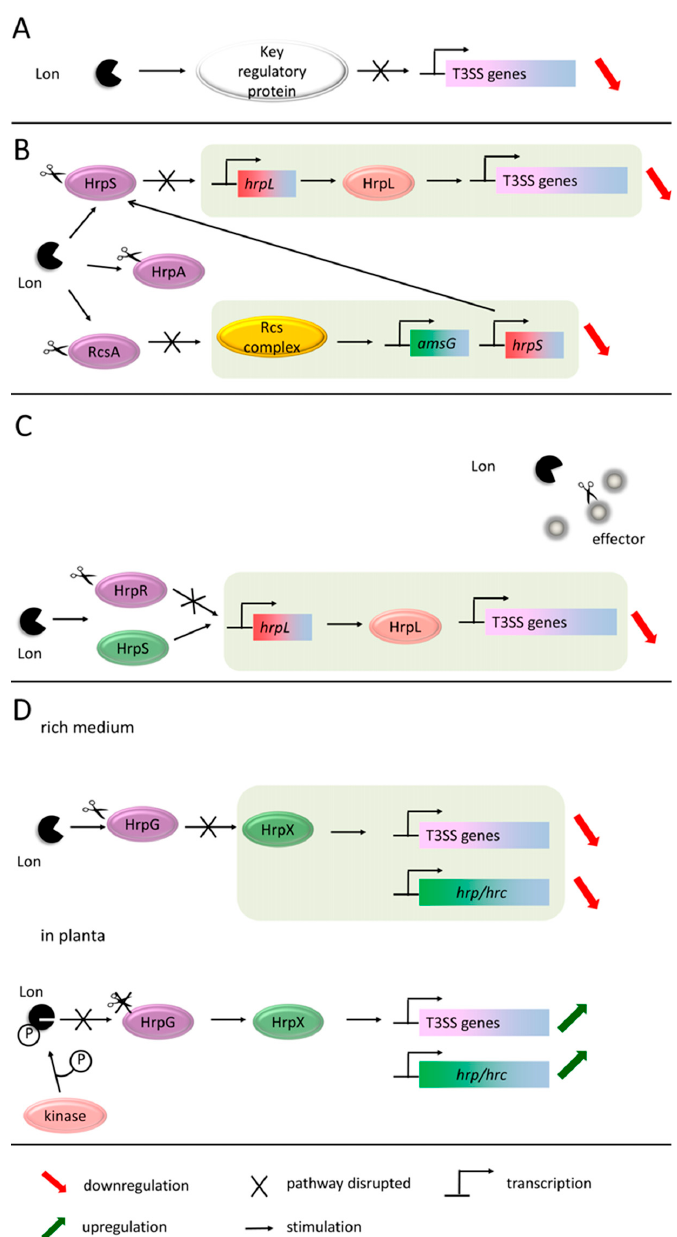
Figure 7. The Lon protease acts as a negative regulator of the Type III secretion system. ( A ) Lon functions through the degradation of the key regulatory proteins—a general scheme [64,180,183]. ( B ) In E. amylovora, Lon negatively regulates T3SS at multiple levels. First of all, it degrades HrpS, a positive regulator of the hrpL gene expression [180]. Moreover, Lon cuts the RcsA component of the RcsA/RcsB complex, involved in activation of the hrpS gene transcription. Lon also targets directly components of T3SS (e.g., it degrades HrpA, a structural protein of the pilus) [184]. ( C ) P. syringae Lon downregulates the T3SS expression by the proteolysis of HrpR, a component of the enhancer complex HrpR–HrpS that stimulates transcription from the hrpL promoter [64]. Additionally, Lon degrades the effector molecules prior to their export [187]. ( D ) In X. citri subsp. Citri, phosphorylation on Lon is responsible for the differential expression of T3SS in the external and host environments [183]. Under non-host conditions, Lon is an active protease and it degrades HrpG, a master regulator of T3SS. A deficiency of HrpG prevents the hrpX gene expression, whose product is necessary for the transcription of the T3SS associated genes. In planta Lon becomes phosphorylated, which results in the loss of its proteolytic activity. HrpG is stabilized and T3SS is “turned